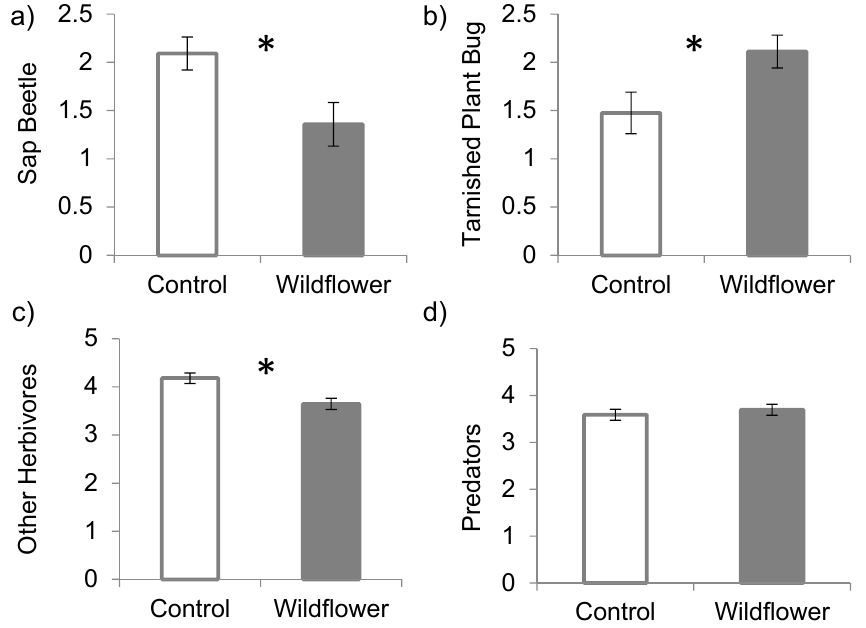
Figure 1. Mean (±SE) abundance of two pests. ( a ) strawberry sap beetle ( Stelidota geminata ); ( b ) tarnished plant bug (Lygus lineolaris ); as well as ( c ) other herbivores and ( d ) predators sampled by vacuum from plots with a control or wildflower border.